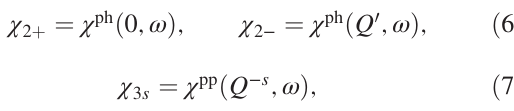
FIG. 3. One-loop corrections to the coupling constants. The solid lines represent the fermion propagators and the wavy lines correspond to interactions. The leftmost diagram involves a particle-particle loop, and the other three diagrams have particle-particle